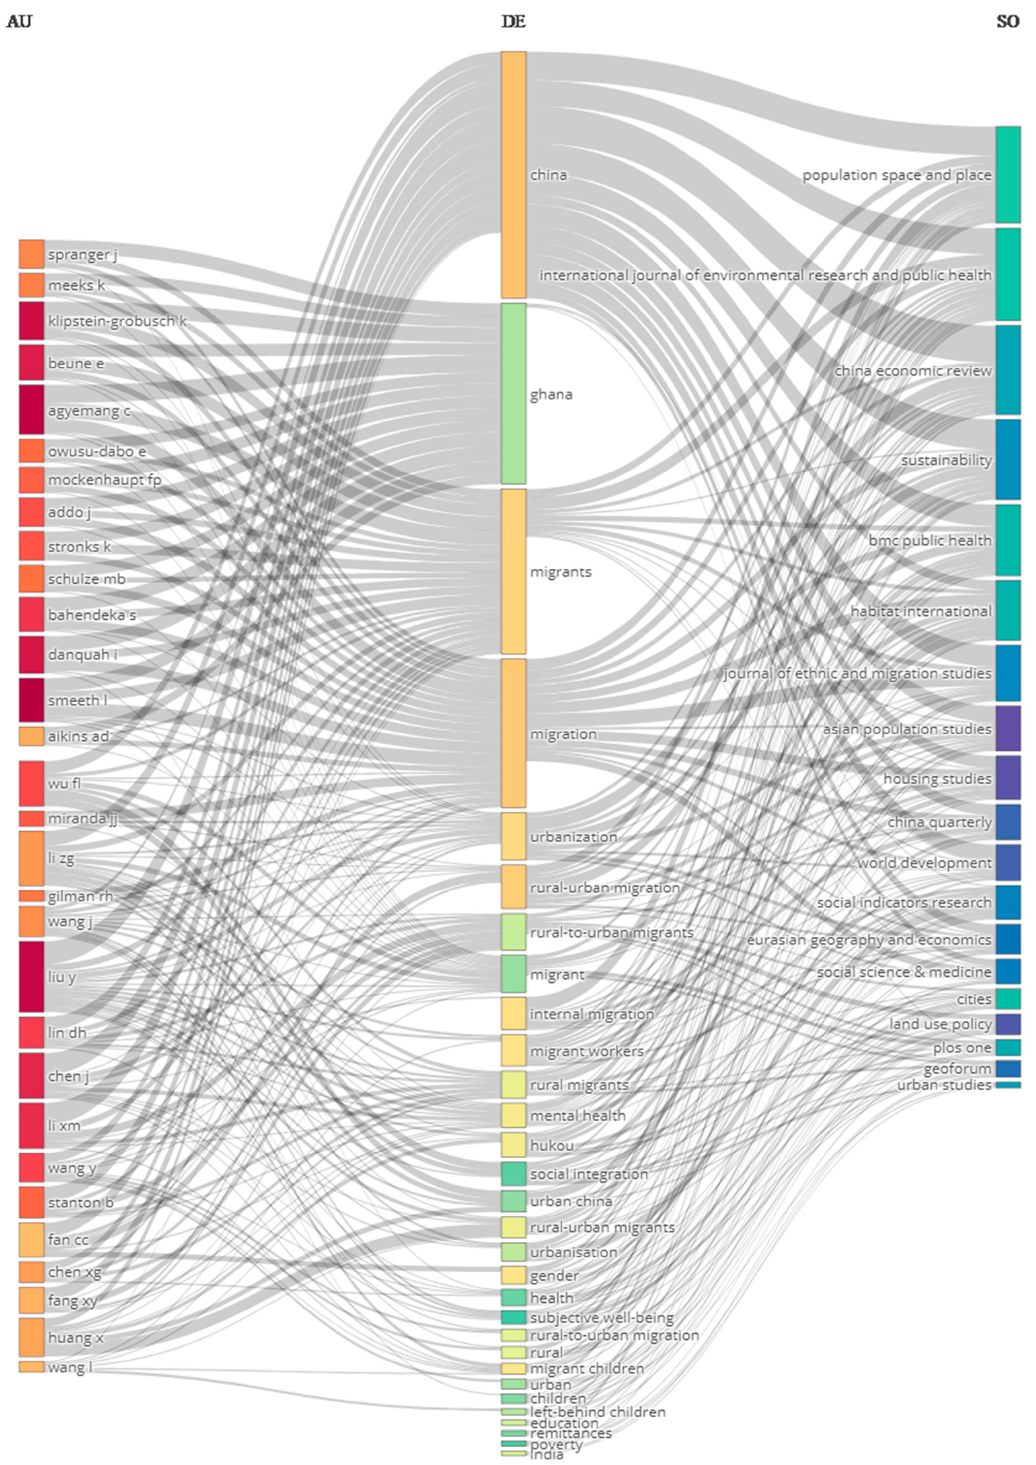
Figure 2. A Sankey diagram showing authors (AU), author keywords (DE), and sources (SO).